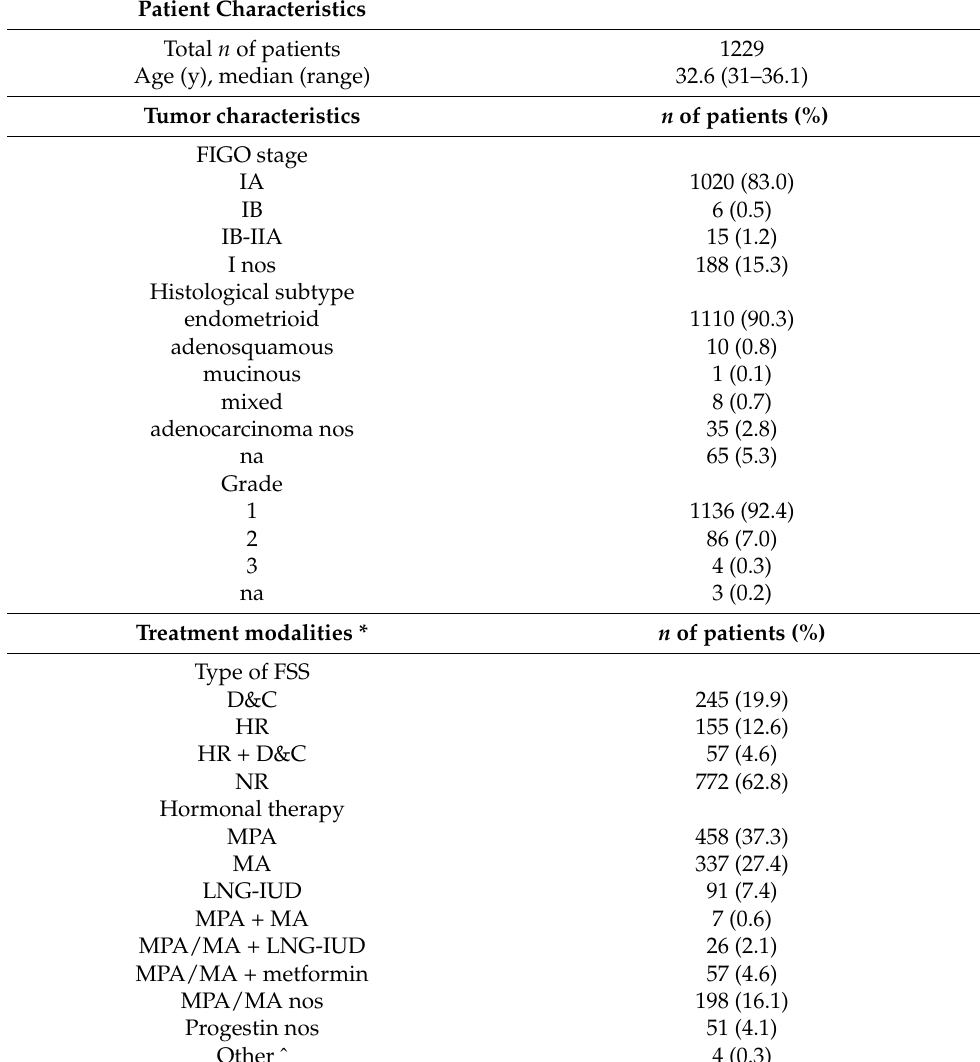
Table 3. Main characteristics and treatment modalities of patients with endometrial cancer undergo- ing